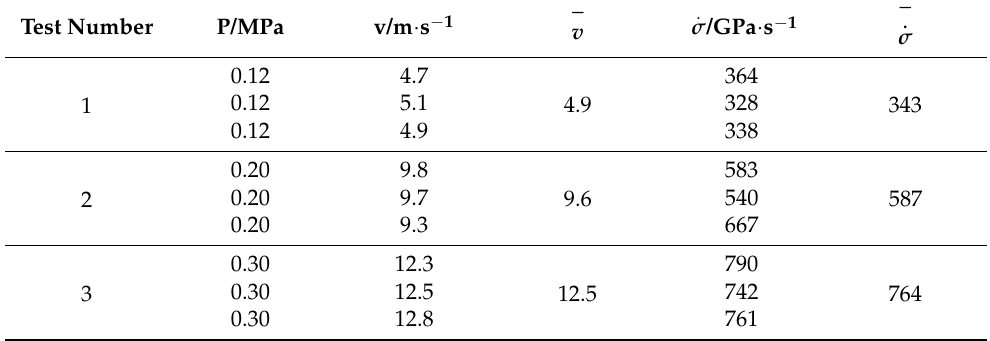
Table 5. Testing speed and loading